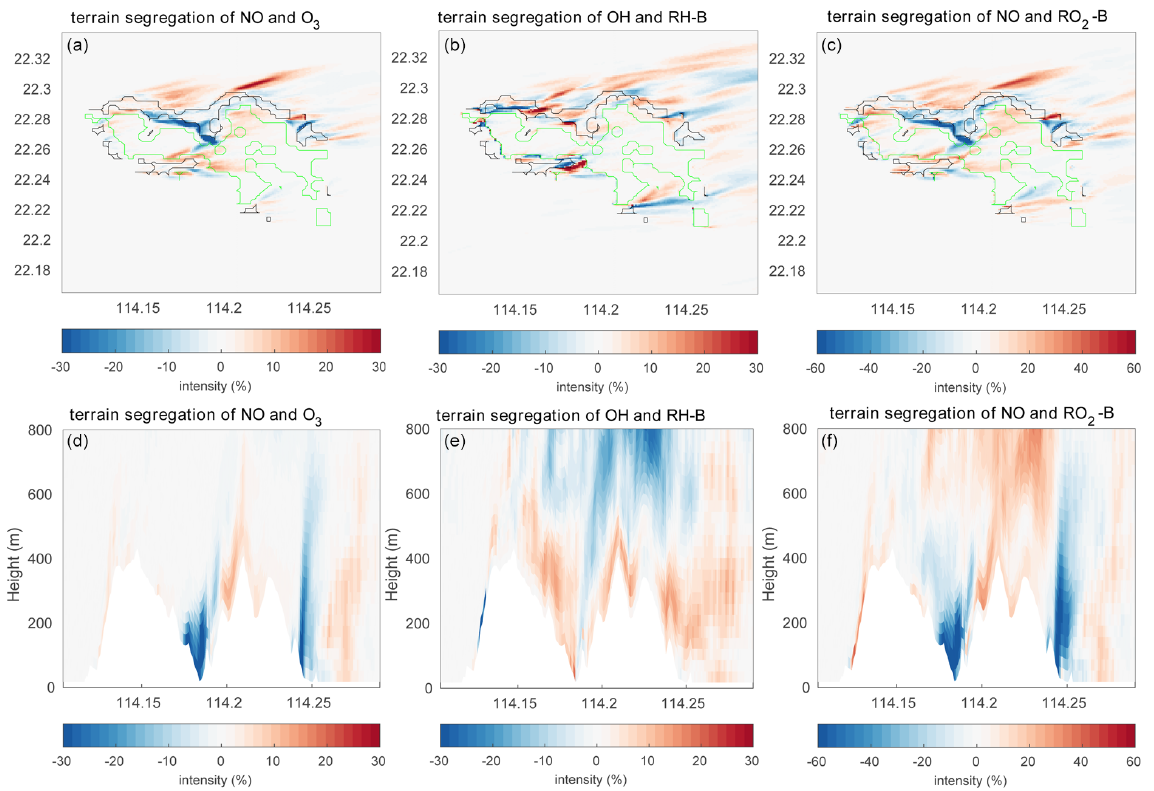
Figure 13. Differences of the segregation intensity between TERW and HETF (TERW − HETF) at the first level (a–c) and the vertical cross section along latitude 22.275 ◦ N (d–f) . The black line shows the urban area, and the green line shows the forest